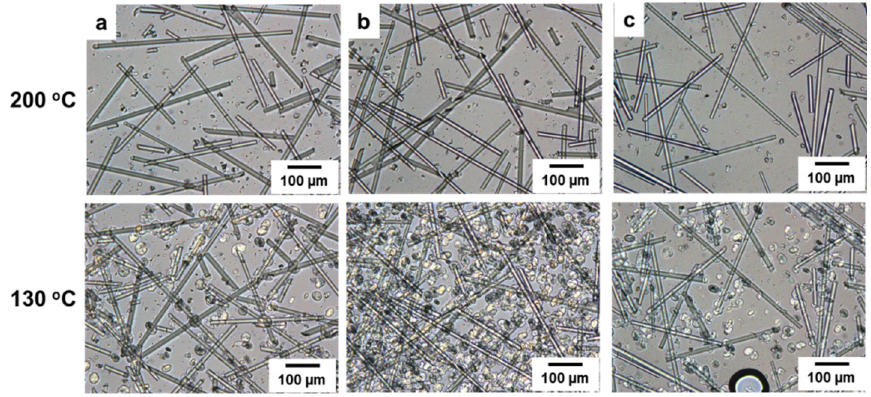
Figure 8. Optical microscopy images (100×) of the PP/SGF composites that are composed of ( a ) 0 wt % of a coupling agent; ( b ) 8 wt % of PP-g-MA as a coupling agent; and ( c ) 8 wt % of SEBS-g-MA as a coupling agent. Table 4. Thermal behaviors of PP/SGF composites.